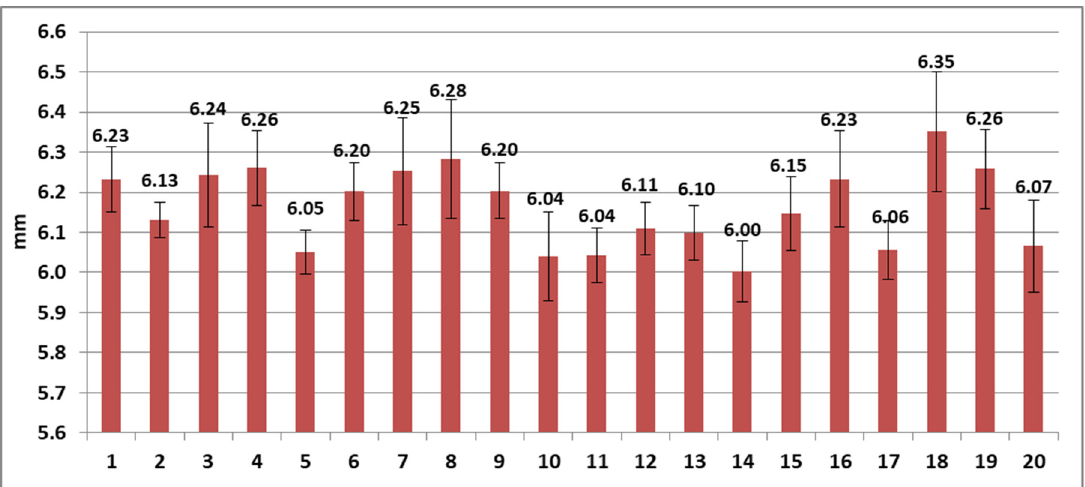
Figure 13. Mean diameter values (mm) of the 20 pellet brands examined.